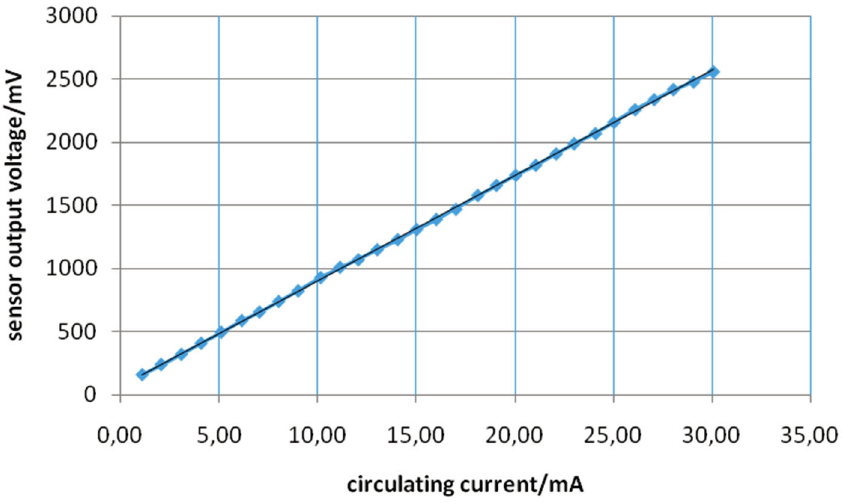
Figure 14. Relation between I f and the sensor output voltage after the amplifying/filtering